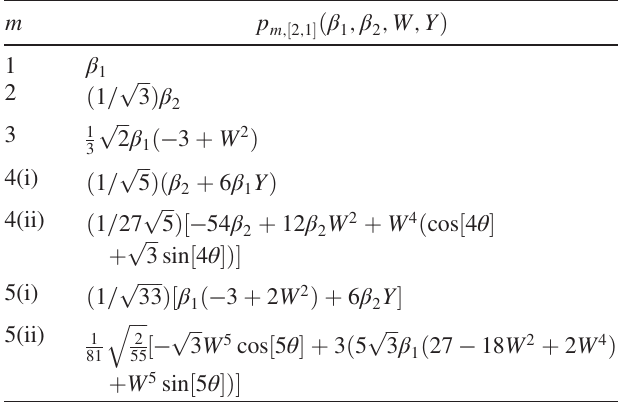
TABLE V. The polynomials p m for the first few N ¼ 3 -body , i.e., λ ¼ ½ 2 ; 1 (cid:2) channel. PPs for bosons in the total spin j S j ¼ 1 2 The primitive polynomials β 1 and β 2 are given by Eqs. (33) and (34). The cos 4 θ ; sin 4 θ ; cos 5 θ ; sin 5 θ can all be decomposed into the elementary symmetric polynomials and primitive